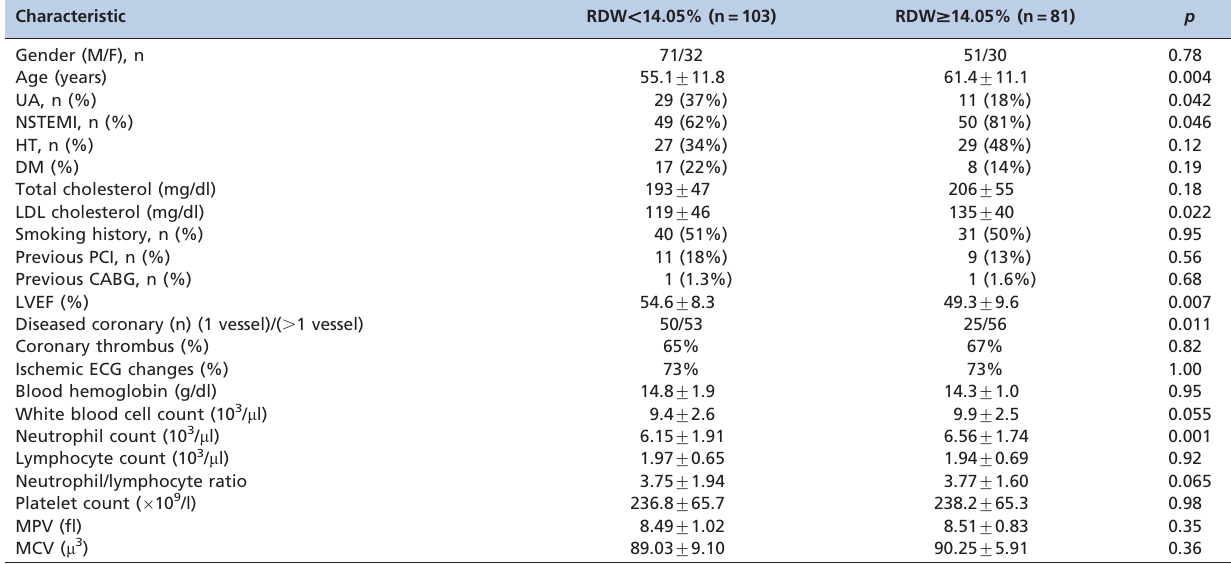
Table 3 - Baseline characteristics of the entire cohort, stratified by the upper tertile of the baseline RDW values ( $ 14.05% vs , 14.05%).